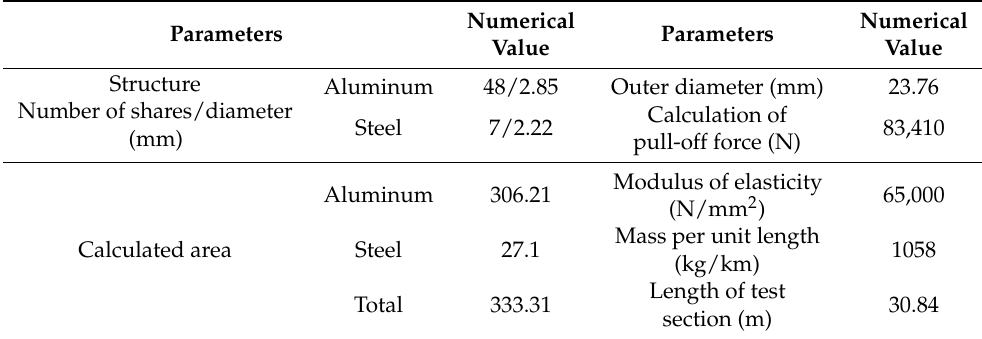
Table 1. Transmission wire parameter